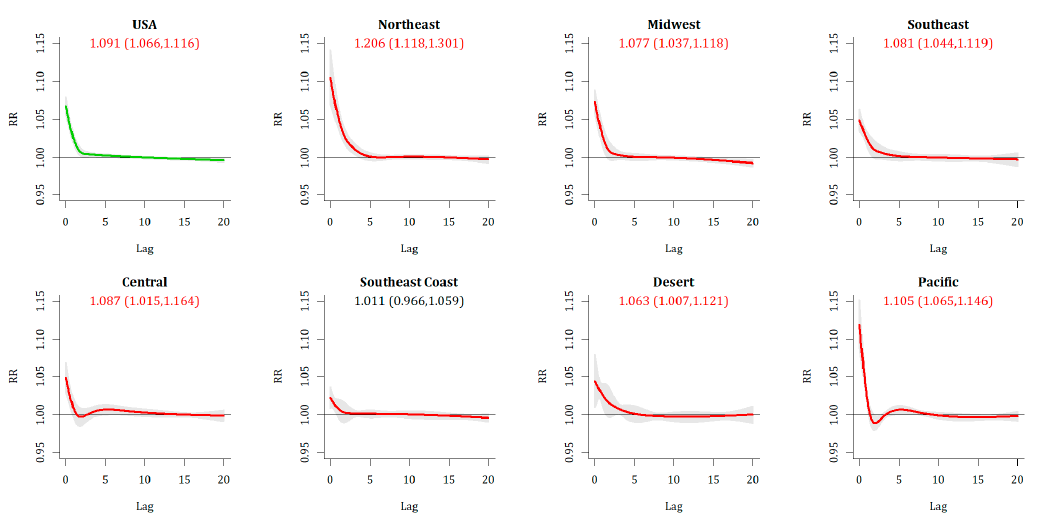
Figure 3. Same as Figure 2, except for EHE.